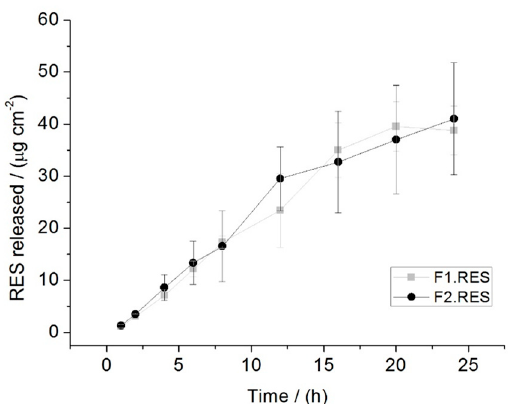
Figure 4. Trans-resveratrol (tRES) release profile from SLN after 24 h of analysis (n = 6). F1.RES comprised 5.0% SA, 3.5% P407, 0.18% MP, 0.02% PP, and 0.1% tRES, and F2.RES comprised 5.0% SA, 1.2% SPC, 3.5% P407, 0.18% MP, 0.02% PP, and 0.1% tRES.